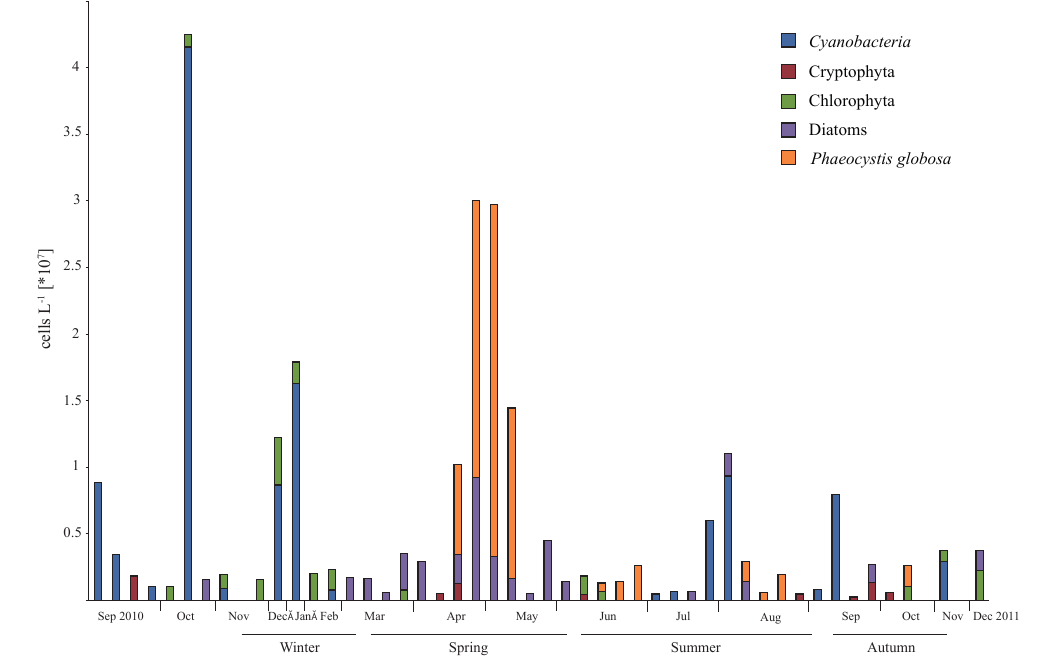
Figure 2. Phytoplankton diversity and abundance (measured in cellsL − 1 ) observed in the coastal North Sea between August 2010 and December